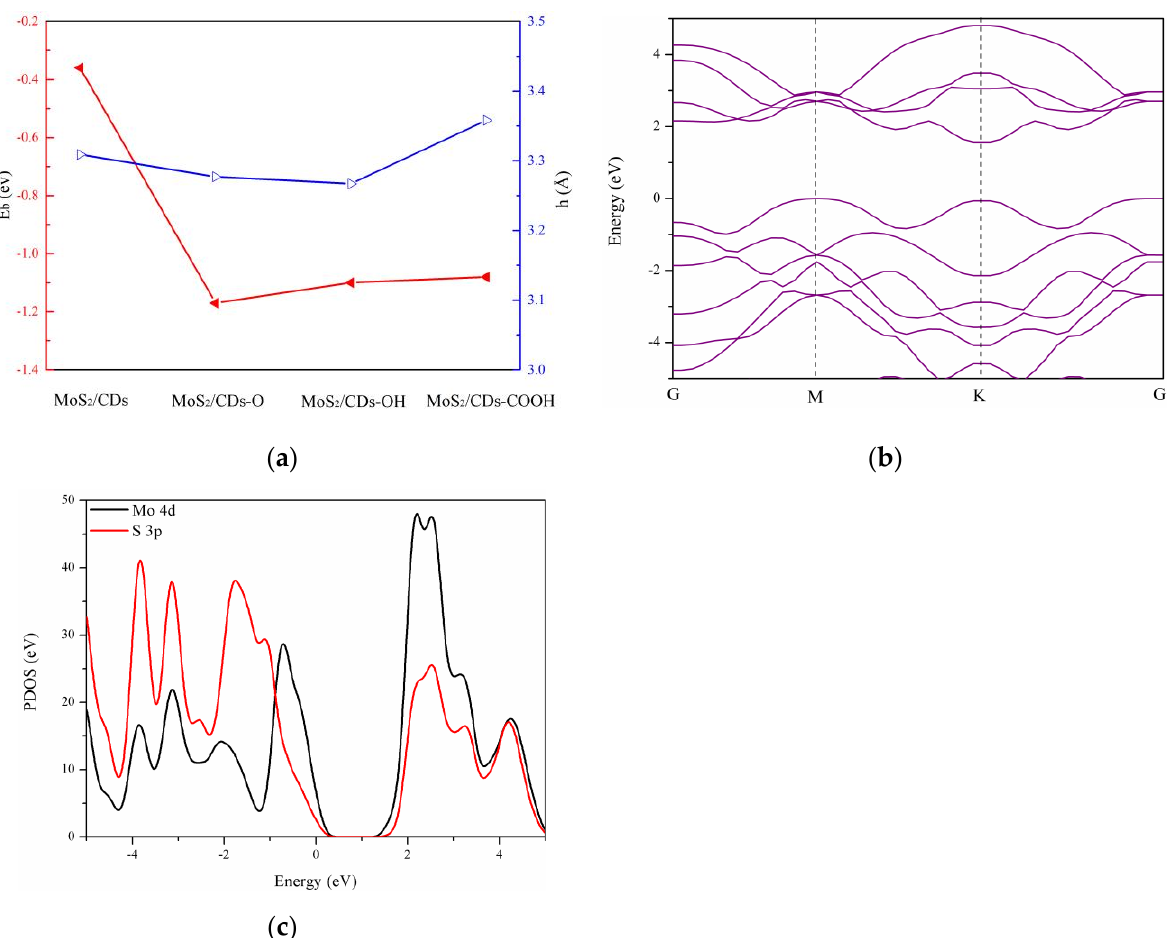
Figure 1. Geometrical structures of MoS 2 monolayer ( a ), CDs ( b ), MoS 2 /CDs heterostructures with- out groups ( c ), MoS 2 /CDs heterostructures with carboxyl ( d ), hydroxyl ( e ), and carbonyl ( f ).